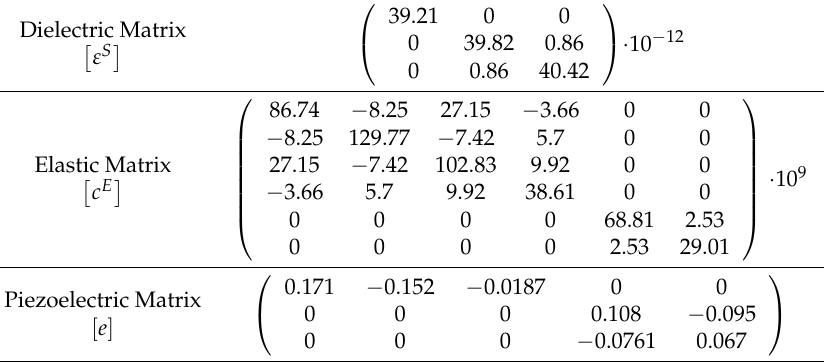
Table A1. Values of the piezoelectric, dielectric and elastic constants of the AT-cut Quartz. Dielectric Matrix (cid:2) (cid:3) ε S